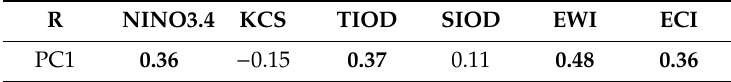
Table 7. Correlation coe ffi cients (R) between PC1 and the SST indices-based predictors (bold font indicates statistically significant values at the 5% level).